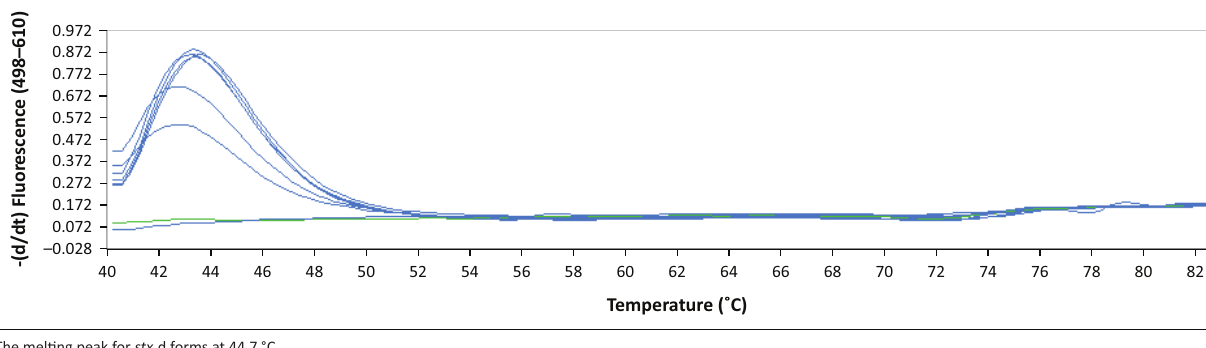
The melting peak for stx 1 d forms at 44.7 °C. FIGURE 6: Melting peaks for the detection of stx